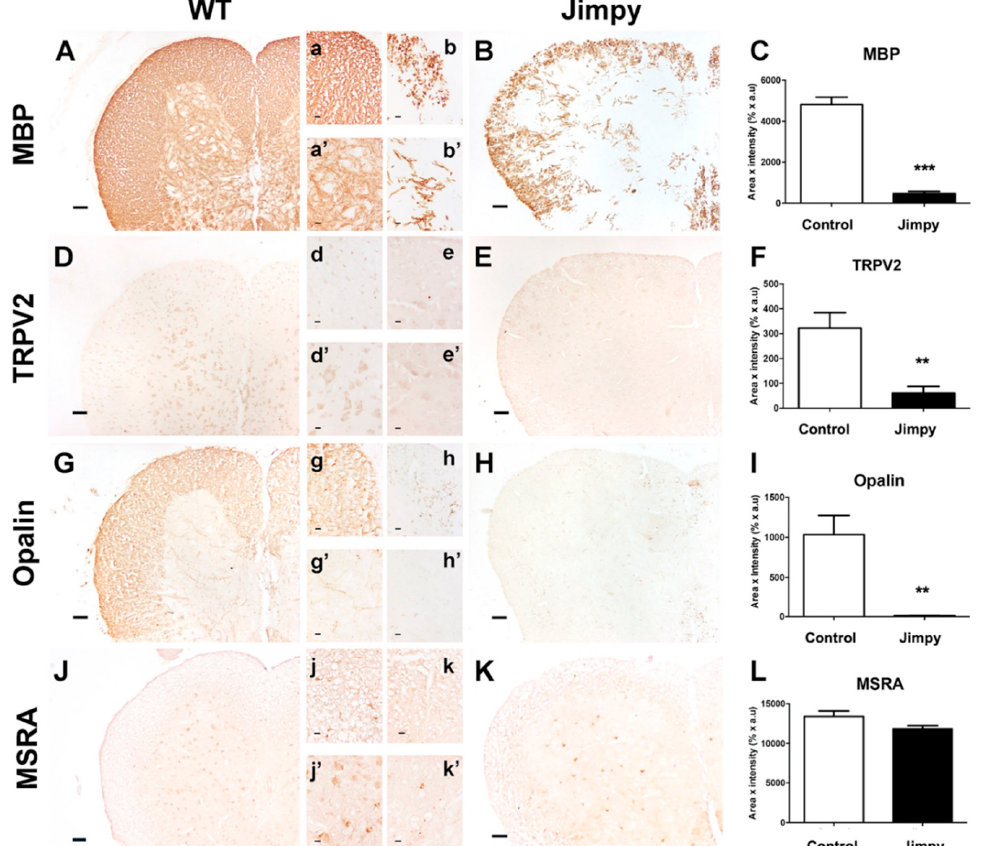
Figure 3. TRPV2, Opalin and MSRA expression in spinal cord of wild-type (WT) and hypomyelina- tion jimpy mice. Immunohistochemical staining against MBP ( A , B ), TRPV2 ( D , E ), Opalin ( G , H ) and MSRA ( J , K ) were performed in spinal cord sections of 21-day-old WT and jimpy mice, and immunore- activity was quantified and analyzed as Area x Intensity. Results show that MBP was importantly reduced in both GM ( a , b ) and WM ( a’ , b’ ) of jimpy mice compared to WT ( A – C ). TRPV2 expression was mainly located in neurons in GM ( d’ ) and glial cells, putatively oligodendrocytes, and in WM ( d ) of WT. A significant decrease in TRPV2 expression in the spinal cord of jimpy mice was observed compared to WT ( E , F , e , e’ ). Opalin expression was importantly found in WM of WT mice ( G , g ), and to a lesser extent also in GM ( g’ ), but showed a marked decrease in WM and GM of jimpy mice ( H – I , h , h’ ). MSRA was the only molecule that did not suffer an important reduction of its expression in both WM ( j , k ) and GM ( j’ , k’ ) in jimpy mice ( L ). Results were expressed as mean ± SEM. Statistical analysis of the results were performed with an unpaired Student’s t -test (** p < 0.01, *** p < 0.001). Scale bar ( A – K ) = 50 µ m; ( a – k , a’ – k’ ) = 20 µ